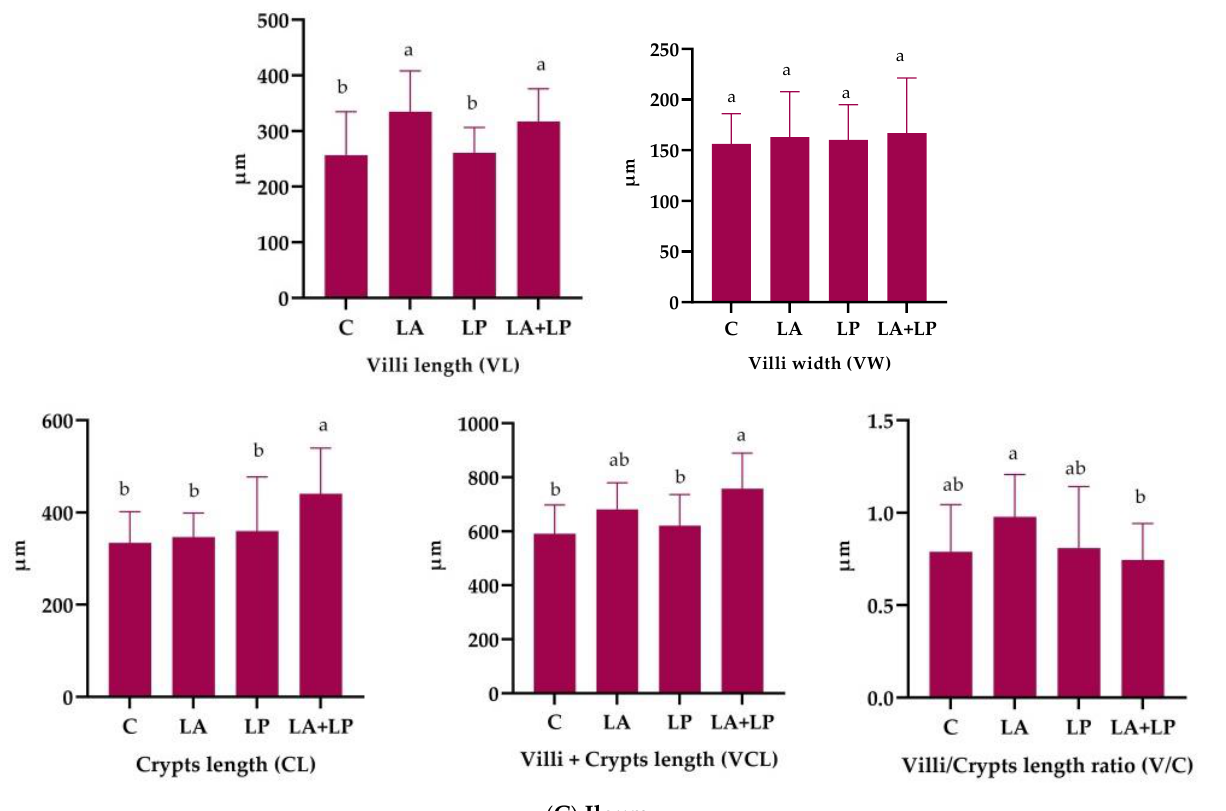
Figure 1. Effects of microencapsulated probiotics supplements on intestinal histomorphology measurements in the duodenum ( A ), jejunum ( B ) and ileum ( C ) of the weaning piglets (n = 8/group). C — control diet; LA — control diet supplemented with microencapsulated L. acidophilus ; LP — control diet supplemented with microencapsulated L. plantarum ; LA + LP — control diet supplemented with microencapsulated L. acidophilus and L. plantarum . a, b superscripts withing each figure bars represents significant difference among the groups at p < 0.05.